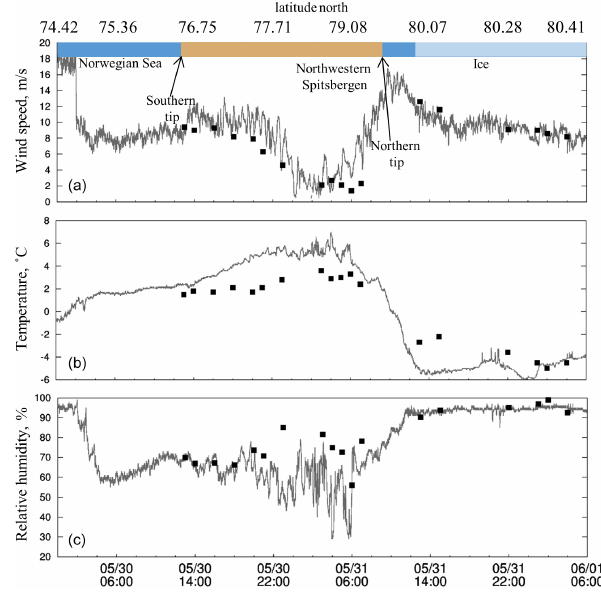
Figure 2. Synoptic chart at 06:00UTC, 30 May 2017, according to ECMWF YOPP analysis: sea-level pressure (black contours, every 5hPa) and air temperature at the 850hPa level (color, every 2K). Arrows show movements of the cyclone center during 29–31 May.